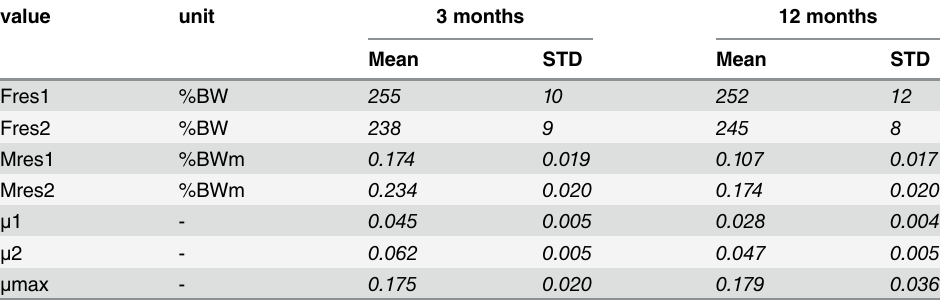
Table 3. Mean values at 3 and 12 months post operative of the ‘ average ’